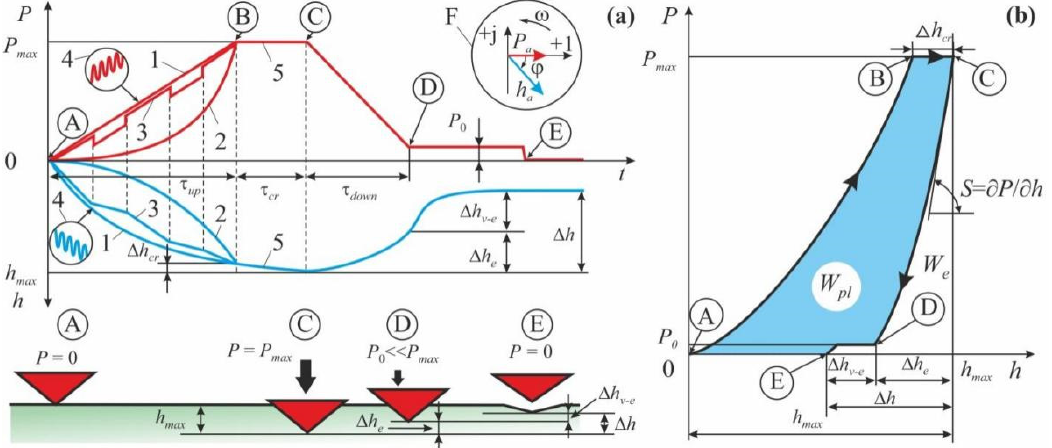
Figure 5. Schematic diagrams of ( a ) the nano-indentometer and ( b ) the atomic-force microscope.